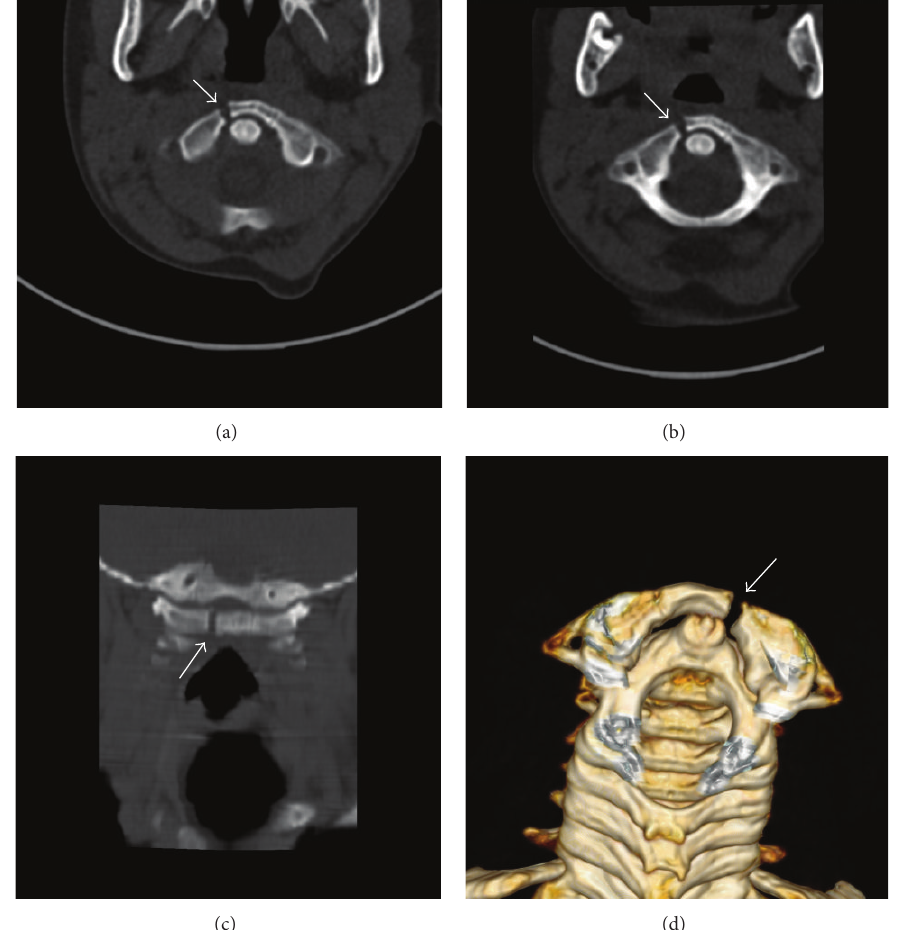
Figure 1: Axial plan, CT scan of cervical vertebrae with 2mm slice thickness (a), axial oblique (b), coronal oblique (c), MIP reconstruction, and posterior view of 3D volume rendering (d) images show fracture of the atlas through a synchondrosis of the anterior arch (arrows). The space at right synchondrosis line is measured 3.5